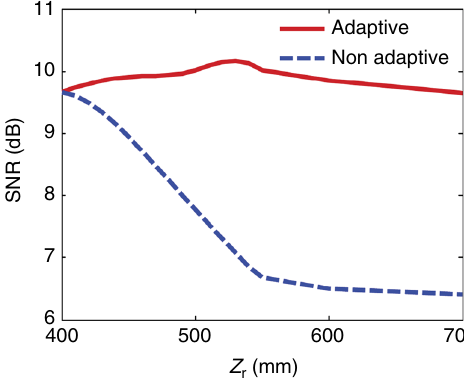
Fig. 6 The dependence of SNR for the holographic image as the function of observation distance. The red line represents SNR for the holographic image as a function of the observation distance with the adaptive adjustment of the metasurface hologram, while the blue dashed line denotes SNR for the holograph image with the observation distance fi xed at Z r = 400 mm. These two lines are obtained by averaging the results of ‘ LOVE PKU!